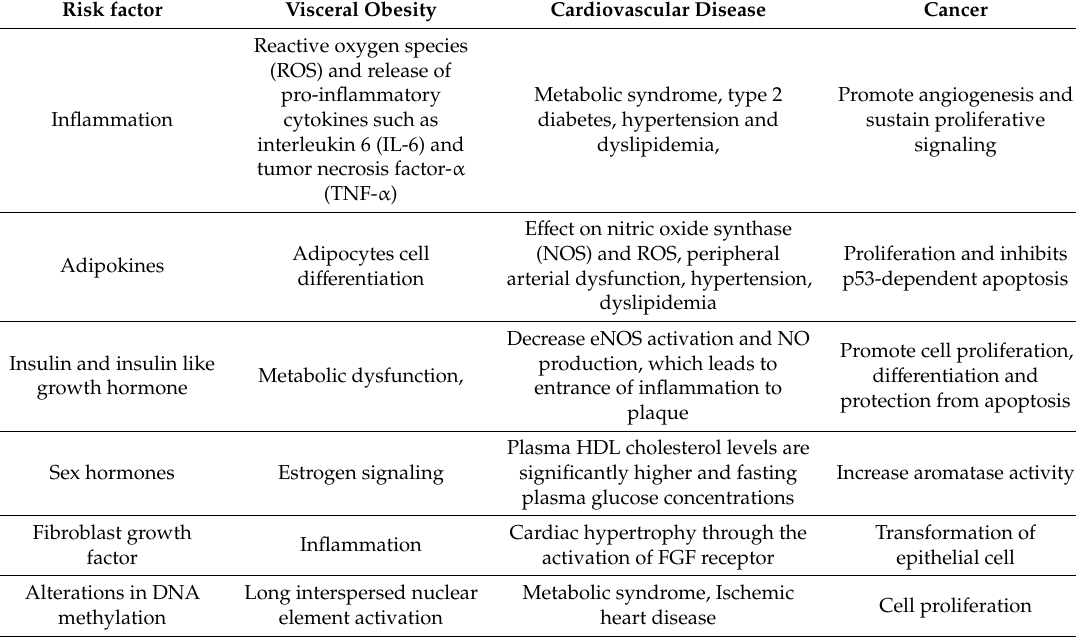
Table 1. Risk factors in visceral obesity, cardiovascular disease and